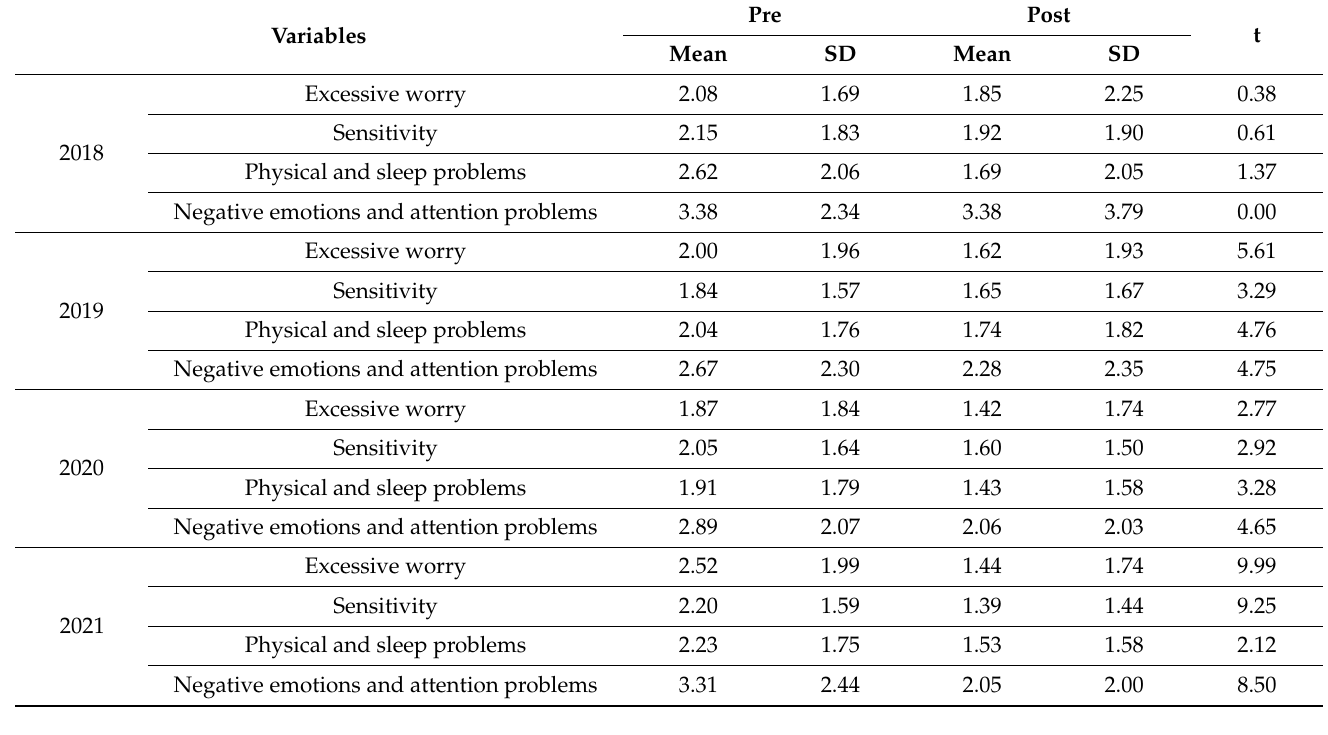
Table 5. Results of RCMAS subdomains for each year 2018–2021.